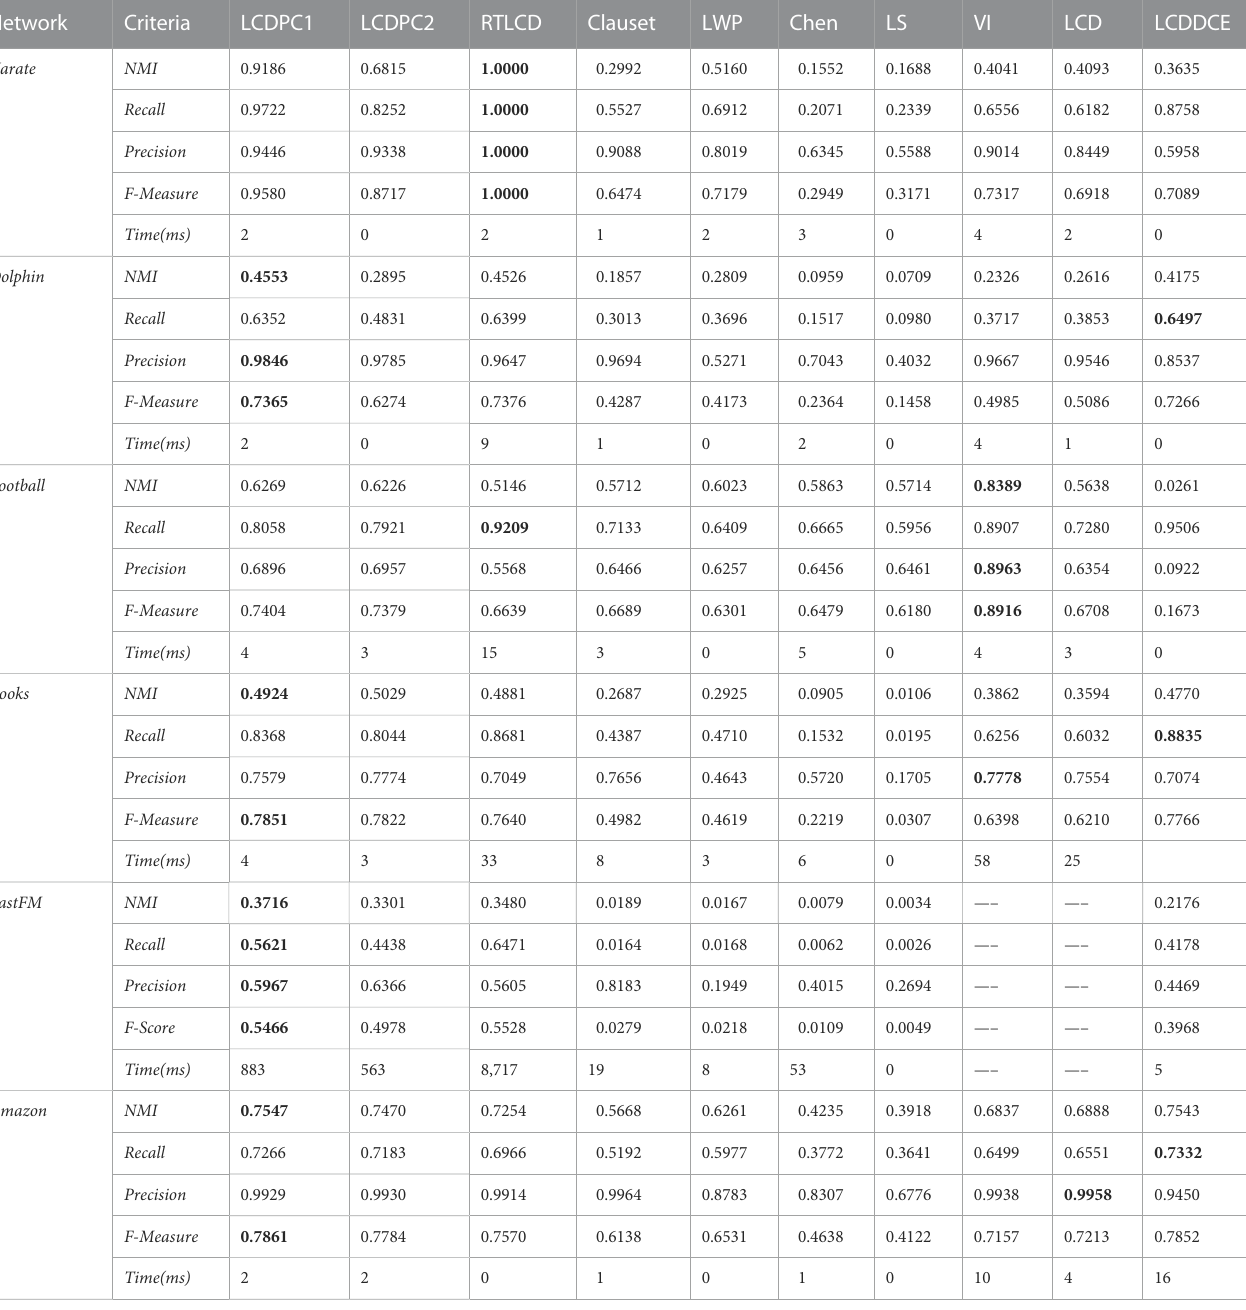
TABLE 5 The algorithm results on real-world networks. The maximum value in a criterion is marked in bold. Network